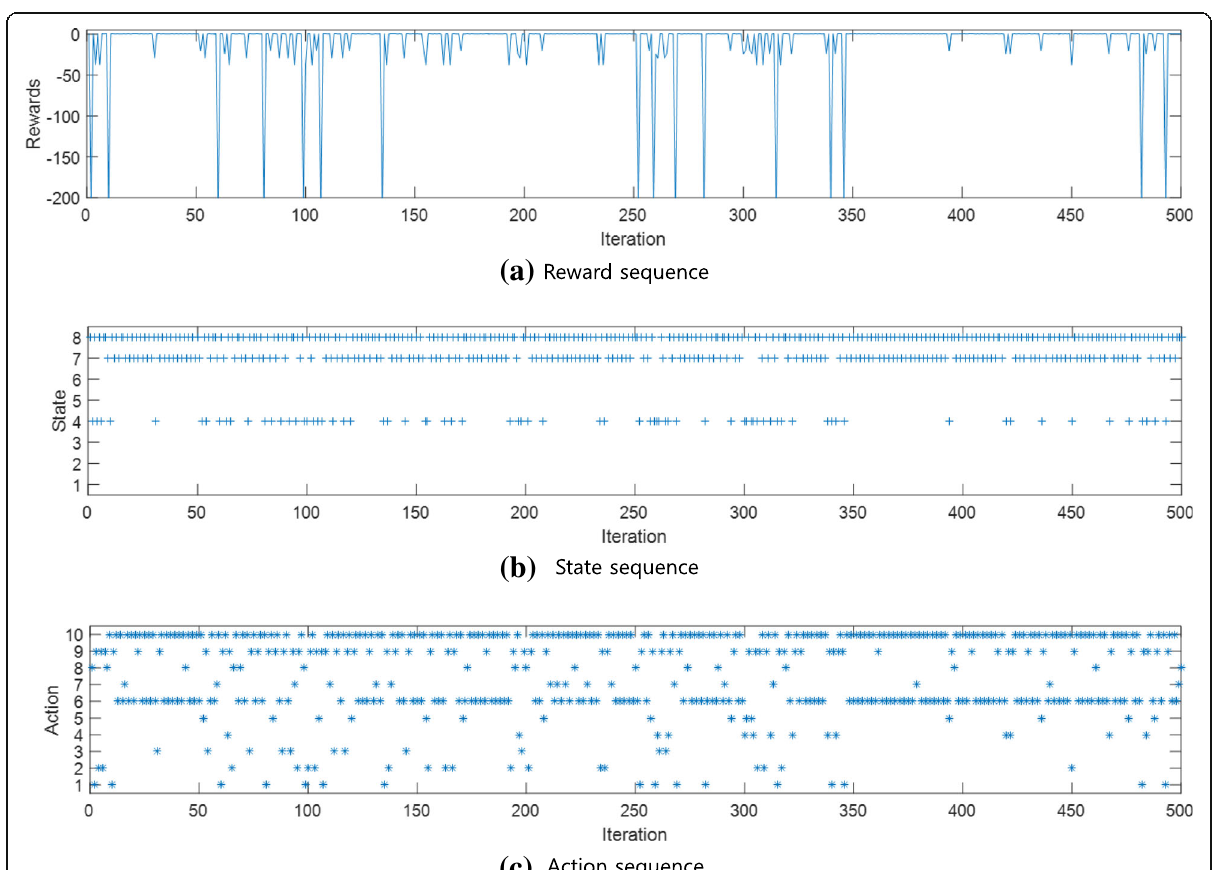
Fig. 16 Rewards, states, and actions according to iteration at DDR = 3.5 Mbps. In a, the reward is stable overall, while it is temporally low in the overall interval by random action, similar to Figs. 12 and 14. In b, the system visits state 4 to a degree, but it mainly remains in states 7 and 8. c shows that actions in band group 2 are selected